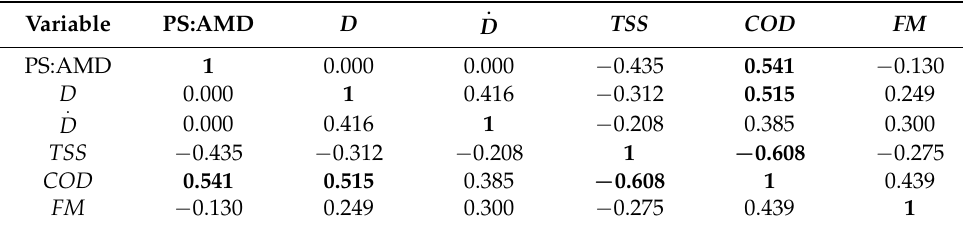
Table 3. Correlation matrix (Pearson = r ) of the studied variables.